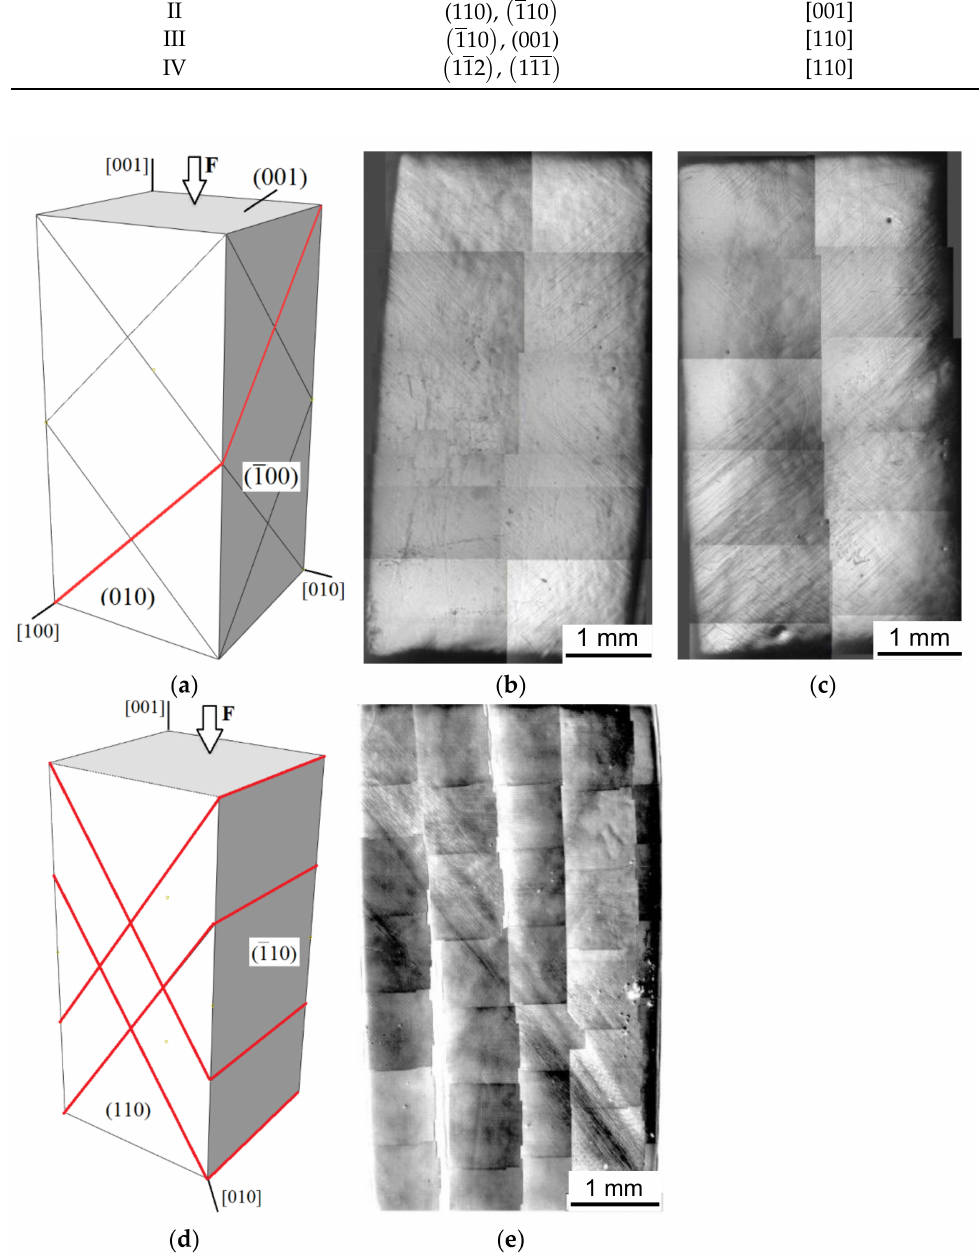
Figure 1. Single crystals with the {100} ( a – c ) and {110} ( d , e ) lateral faces compressed along the [001] direction: crystallographic schemes of {111} slip planes and lines of their intersection with crystal surface ( a , d ); optical images of crystal lateral faces coplanar with the {100} planes at a strain of 0.07 ( b , c ) and with the (110) plane at a strain of 0.05 ( e